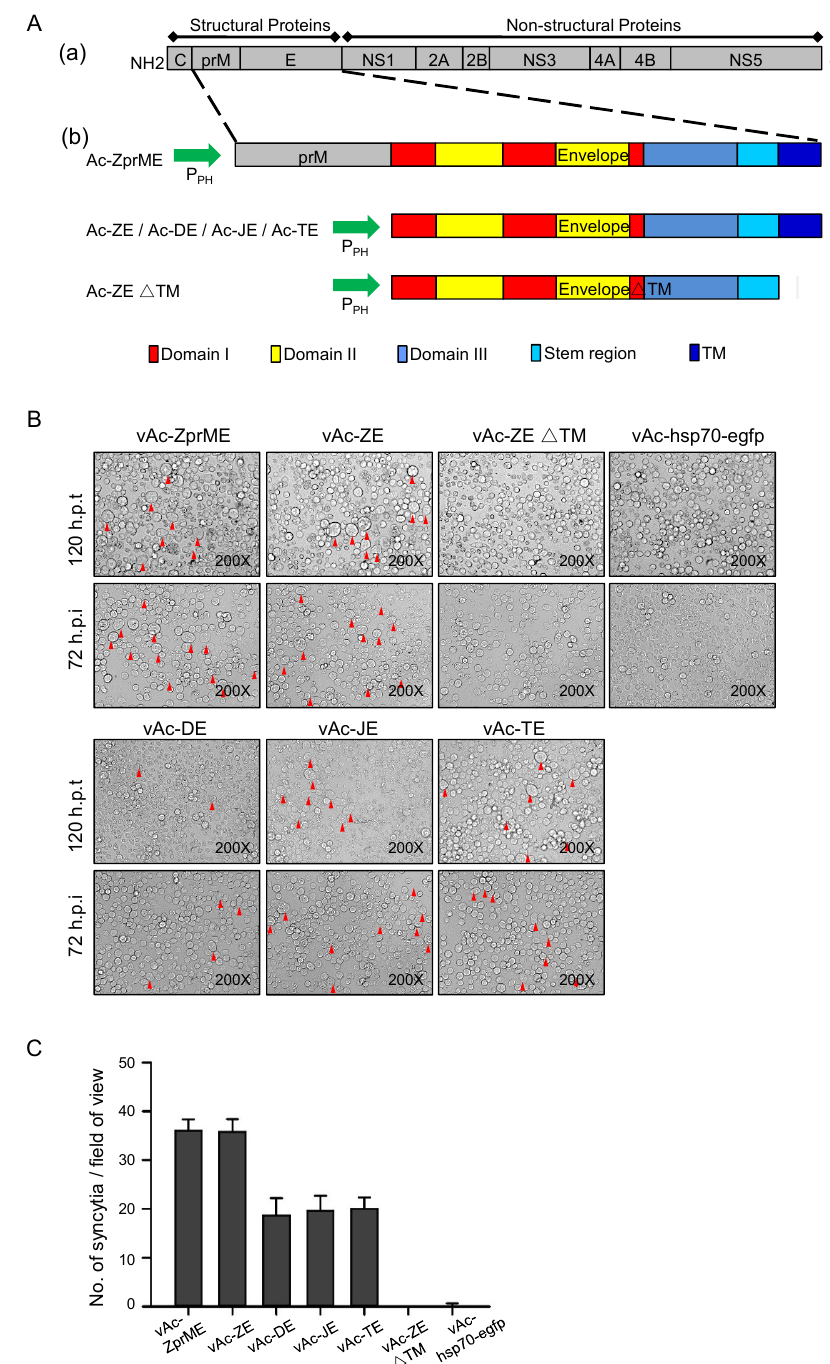
Figure 1. Induction of syncytial formation by baculovirus-expressed flavivirus E